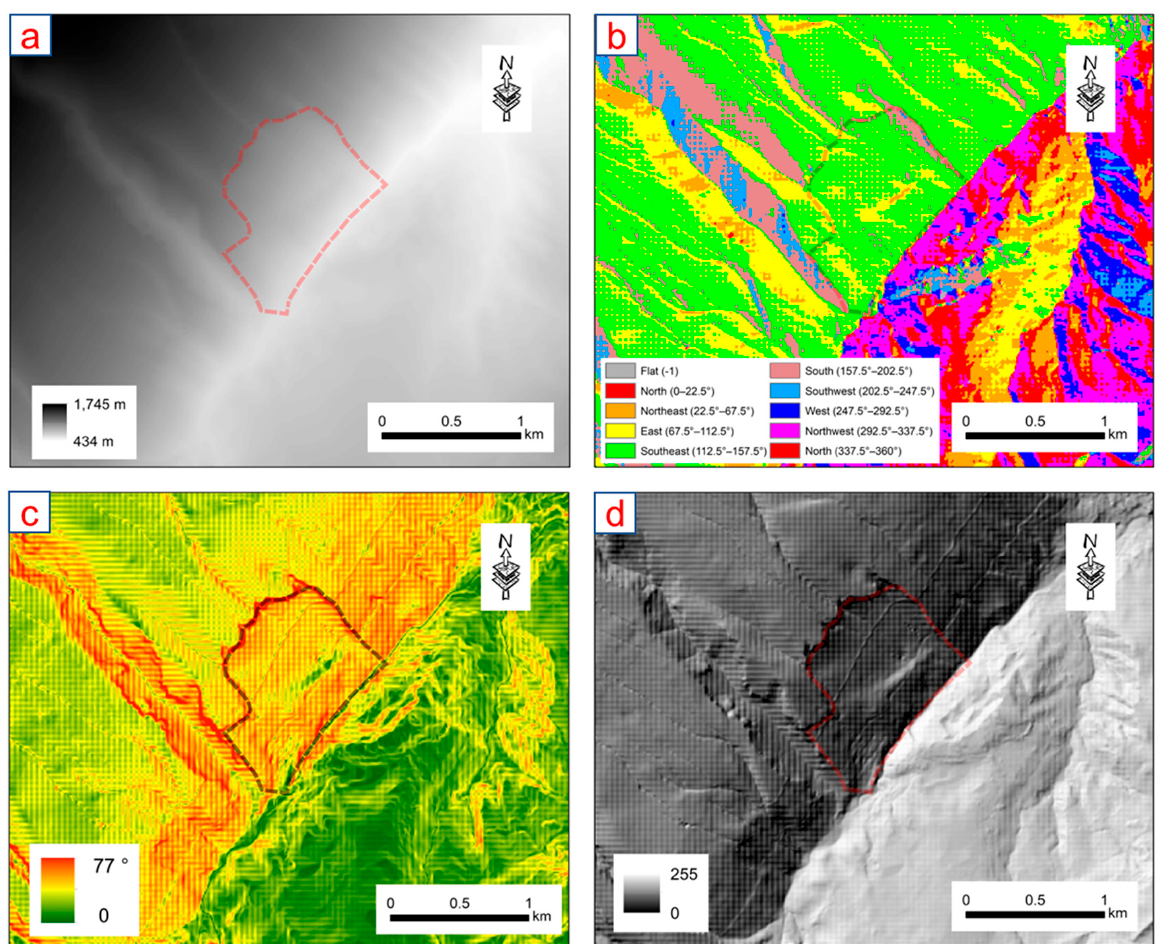
Figure 10. Topography of the analysed slope, showing the information on ( a ) elevation, ( b ) aspect ( c ) inclination, and ( d ) hillshade.